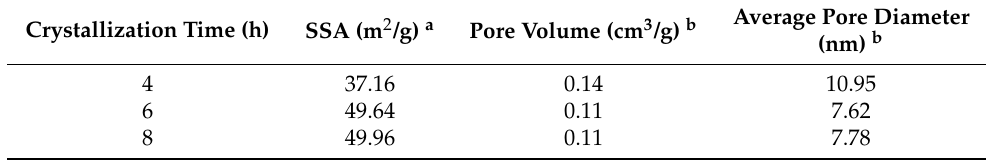
Figure 3. N 2 adsorption-desorption isotherms of BFSZ synthesized at crystallization times of ( A ) 4 h ( B ) 6 h and ( C ) 8 h. Table 3. Microstructural characteristics results of the BFSZ prepared at various crystallization